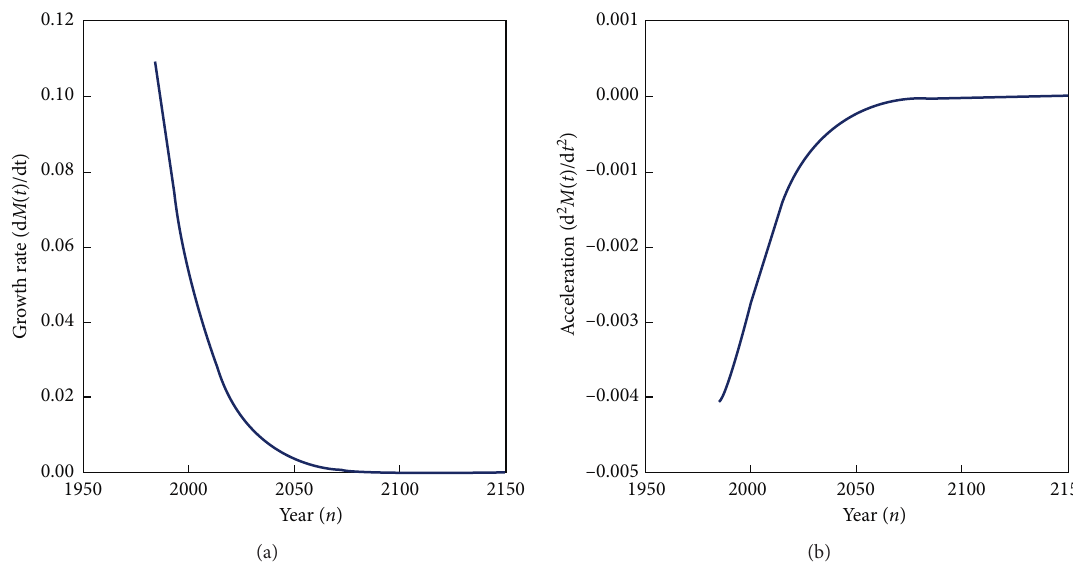
Figure 3: The trend curves of growth rate and accelerated speed of spatial entropy increase of Beijing’s urban form (1984–2150). (a) Growth rate. (b) Accelerated speed. Note: in order to show the change trends of growth rate and accelerated speed of the spatial entropy of Beijing’s urban form, the time span was extended from 1984–2015 to